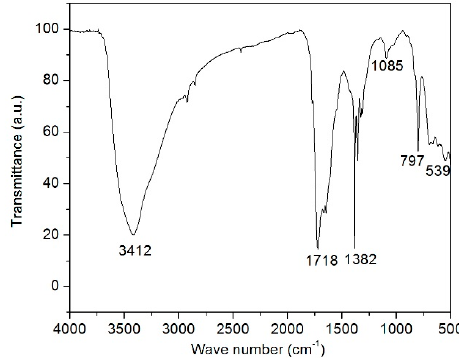
Figure 1. FT-IR spectra of manganese ferrite nano powder.